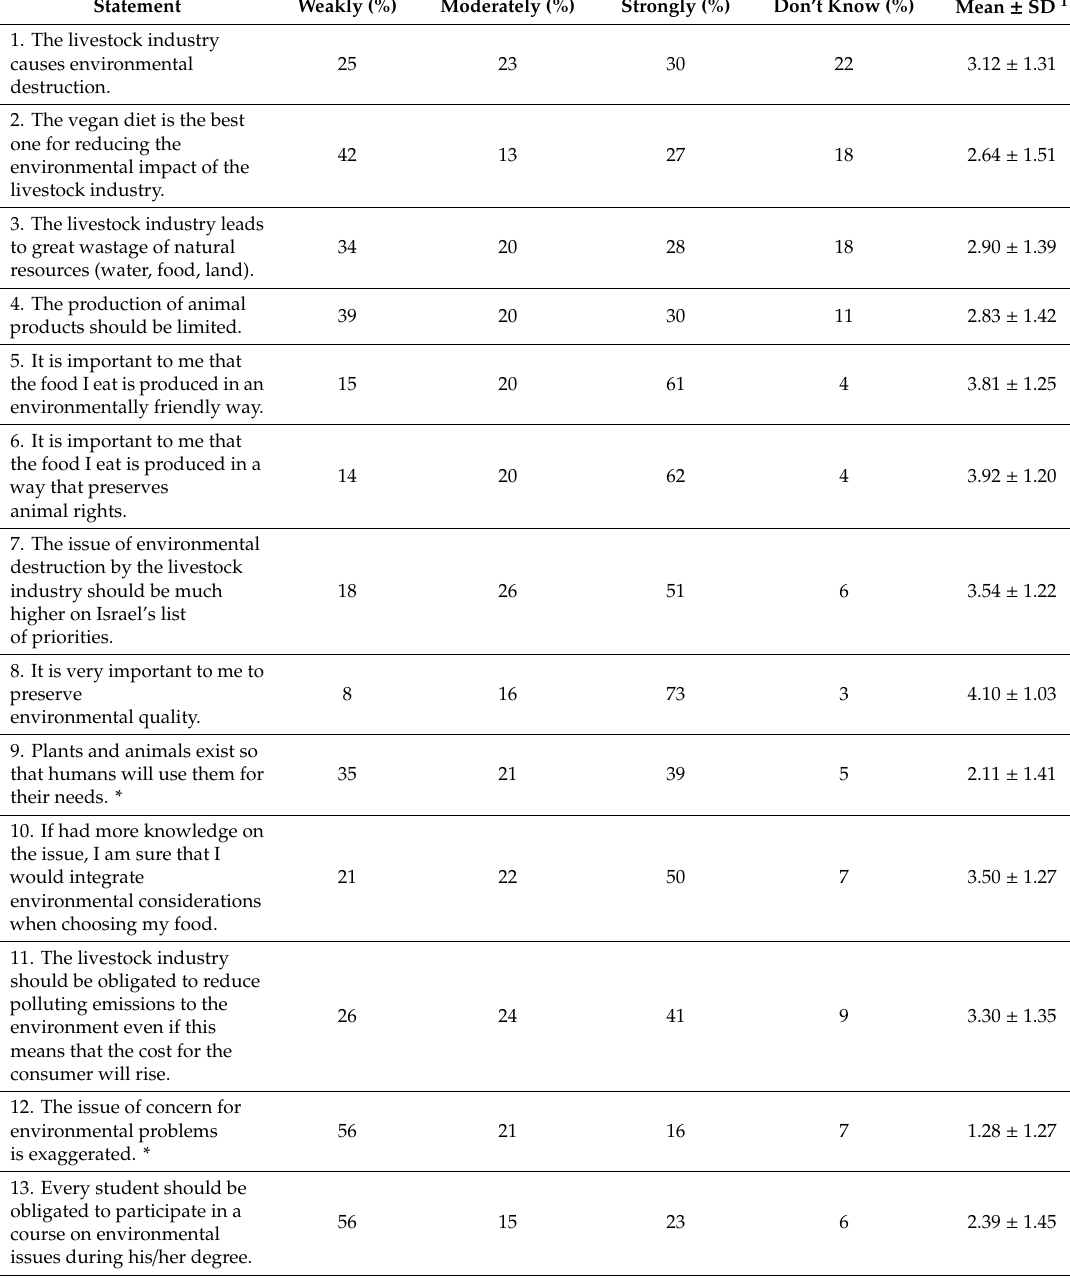
Table 3. Distribution of responses to the attitudes